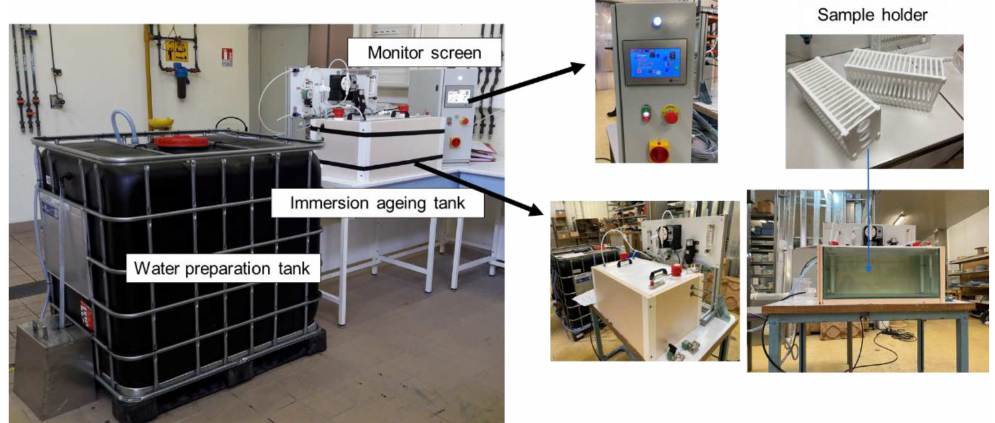
Fig. 5. Design specific accelerated ageing